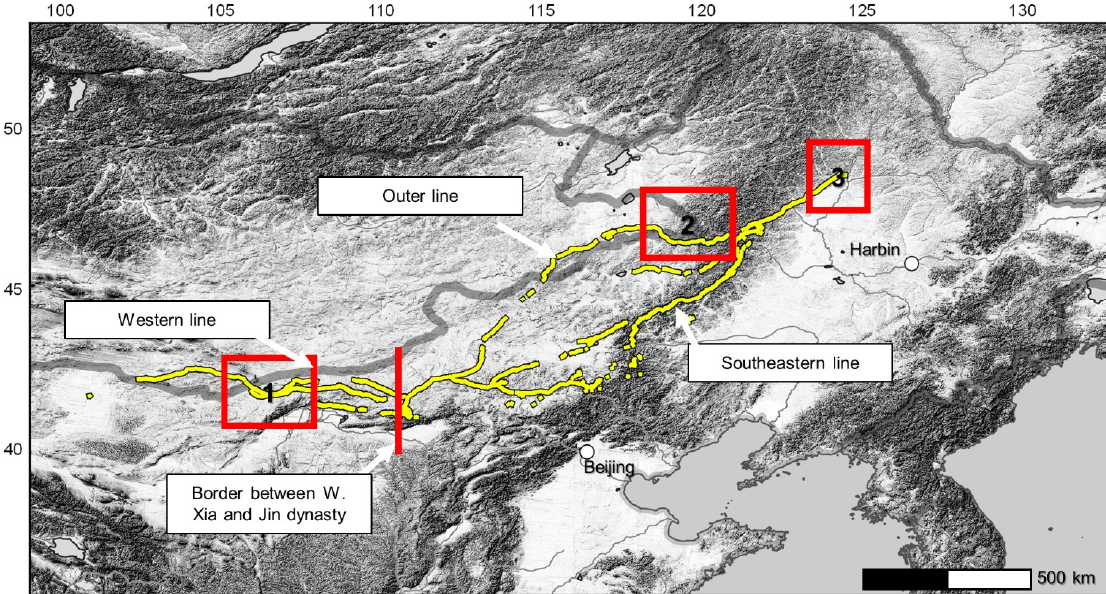
Figure 6. Our comprehensive map of the MWS, with areas investigated using remote sensing: Area 1 is the Gobi Desert, Area 2 is the Mongolian Arch, and Area 3 is the Nierji Dam.